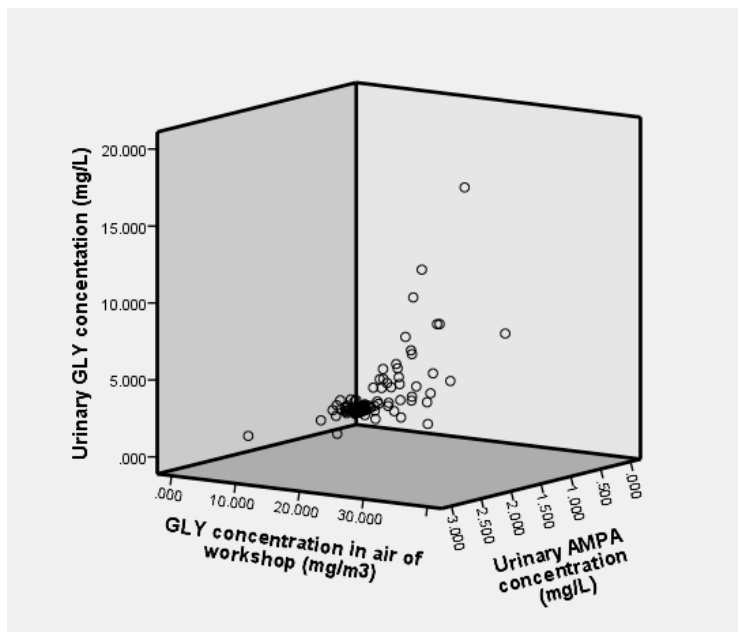
Figure 3. Three-dimensional distribution of internal and external dose.